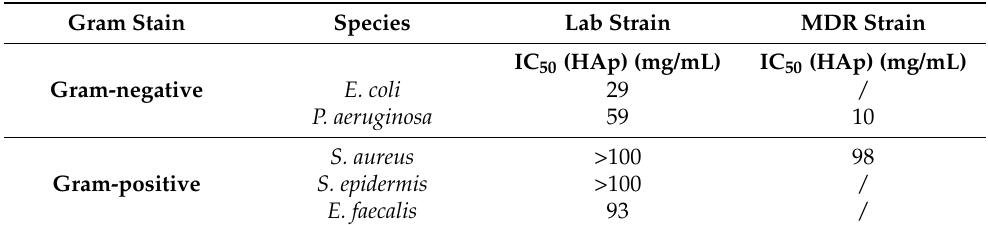
Table 1. IC 50 values for HAp against regular, lab strains and multidrug-resistant (MDR) strains of different Gram-negative and Gram-positive bacteria, as determined from concentration-dependent viability curves in Luria/Vegatone broth assays